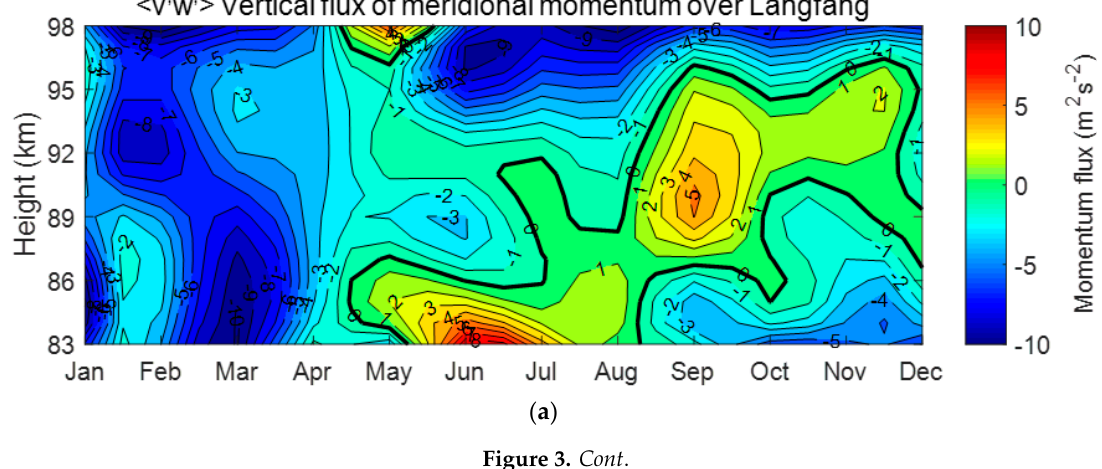
Figure 2. Height-time cross-sections of Lomb-Scargle spectral analysis results for monthly averaged zonal momentum flux (upper panel) and zonal background wind (lower panel) over Langfang. All panels show changes in their respective variables with variations in height and time. The white solid lines indicate a 90% confidence level. ( a ) Vertical flux of zonal momentum spectral analysis over LangFang; ( b ) Zonal wind spectral analysis over LangFang.